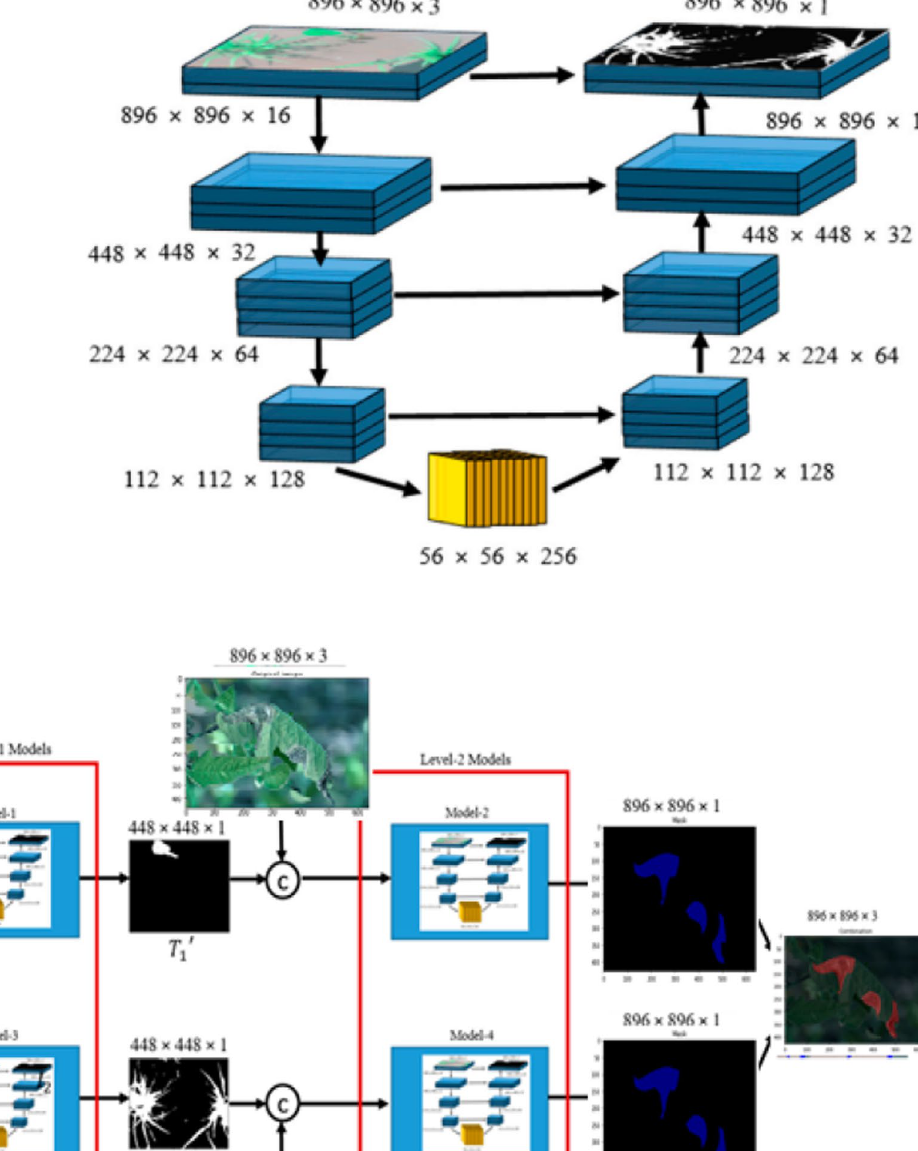
Fig. 9 Single encoder–decoder network